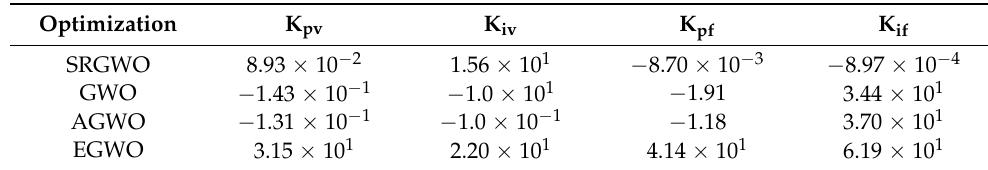
Table 6. The parameters of optimized PI controller. Optimization